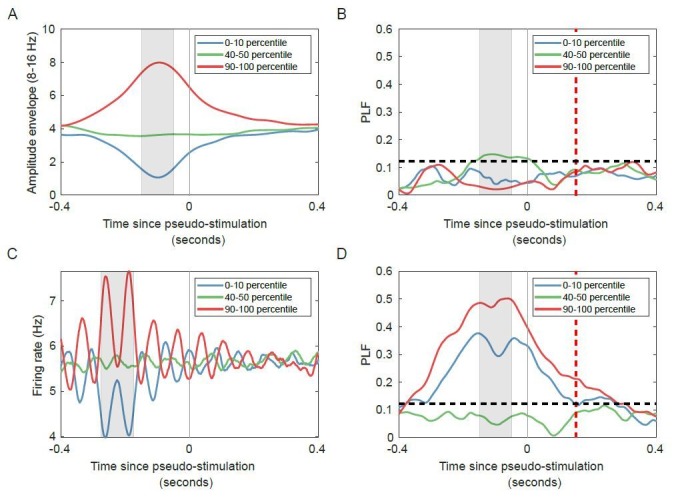
Networks with strong oscillatory activity show regulation of phase-locking by pre-stimulus firing rate, even when the networks are not stimulated.(A) Trial-averaged amplitude for unstimulated networks, with trials split into lowest (blue), medium (green) and highest (red) pre-stimulus (grey window) oscillation amplitude. (B) No significant phase-locking for trials used in (A) in the unstimulated condition. (C) Trial-averaged firing rate for unstimulated networks, with trials split into lowest (blue), medium (green) and highest (red) pre-stimulus (grey window) firing rate. (D) Significant phase-locking for trials used in (C) in the unstimulated condition. Red dashed lines indicate post-stimulus time (equivalent to 25 ms post-stimulus corrected for filter effect), horizontal black dashed lines indicate PLF significance threshold (see Materials and methods).